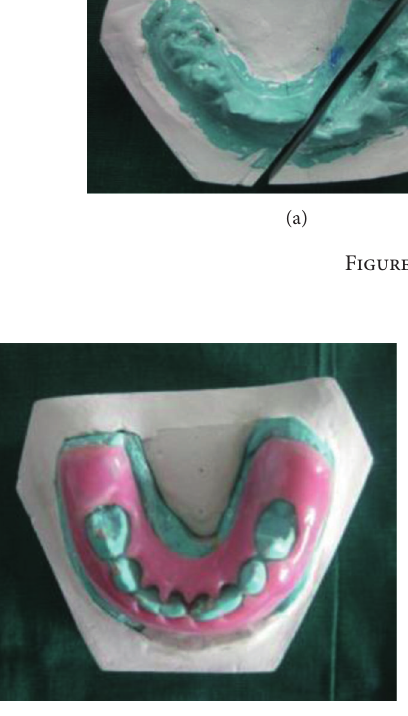
Figure 4: Prefabricated surgical splint on the model.